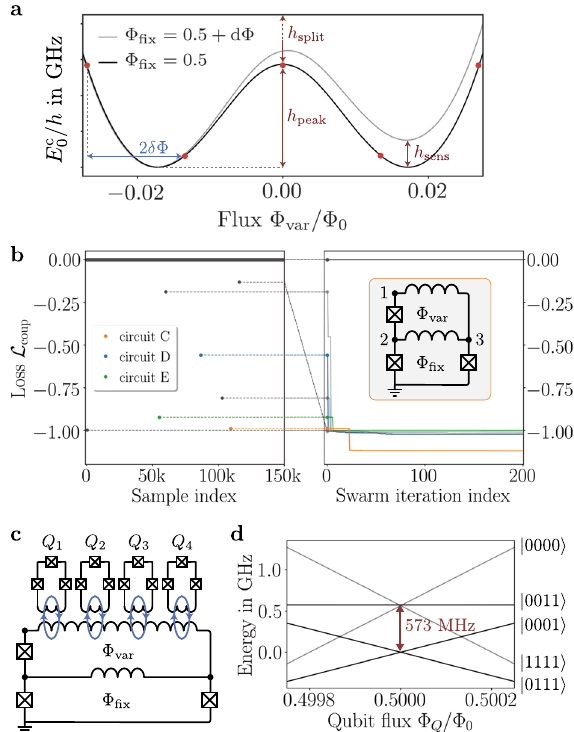
Fig. 4 Automated design and veri fi cation of a 4-local coupler circuit. a Desired double-well spectrum of the ground state versus external fl ux, with the bias points for the 4-qubit excitation manifolds, again shown as red dots. The typical well asymmetry effect of fl ux offsets in the nonprimary external fl uxes is shown in gray. The loss function is constructed from the peak height h peak , excited-state splitting h split , and noise sensitivity parameter h sens . b Loss of the candidate circuits throughout the optimization, starting with 150,000 randomly sampled circuits and followed by re fi nement iterations using swarm optimization. Inset: circuit diagram of the best circuit (circuit C) after re fi nement. c Circuit schematic of the full 4-qubit system, including coupler circuit C. d First 16 energy eigenstates of the full system versus the commonly swept external fl ux in the qubit loops. Darker lines indicate a higher number of degenerate states. The states separate by qubit excitation parity at degeneracy, which corresponds to 4-local coupling between the